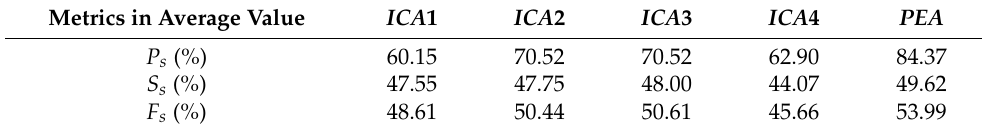
Table 8. General results comparison of REDD-based NILM for individual